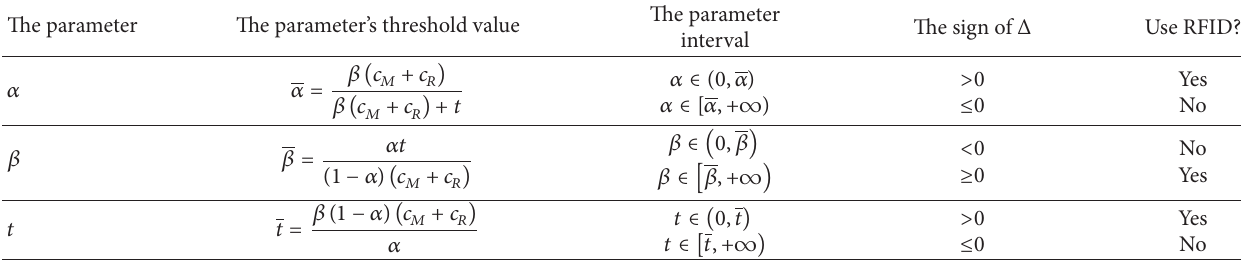
Table 1: Item-level RFID implementation cases for the key parameters 𝛼, 𝛽 , and 𝑡 .